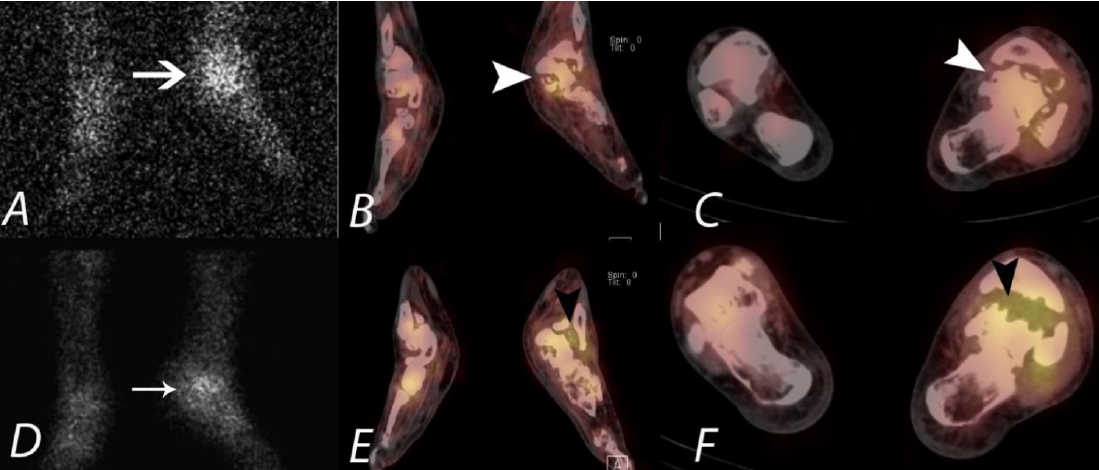
Figure 14. A seventy-year-old diabetic male patient with chronic left midfoot Charcot joint changes was evaluated for possible superimposed infection. Planar image ( A ), coronal fused axial image ( B ), and axial fused axial SPECT/CT image ( C ) from In-111 WBC scan demonstrate focal uptake localizing to mid and hind foot (large white arrow and white arrowheads), which is congruent with uptake identified on Tc-99m sulfur colloid images ( D – F ), supporting the presence of chronic inflammation and granulation tissue and not active infection (small arrow and black arrowheads).